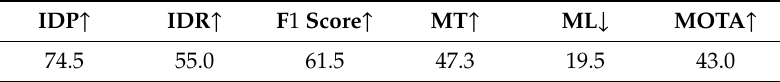
Table 4. The state-of-the-art performance in detection-and-tracking according to [47]. IDP ↑ IDR ↑ F 1 Score ↑ MT ↑ ML ↓ MOTA